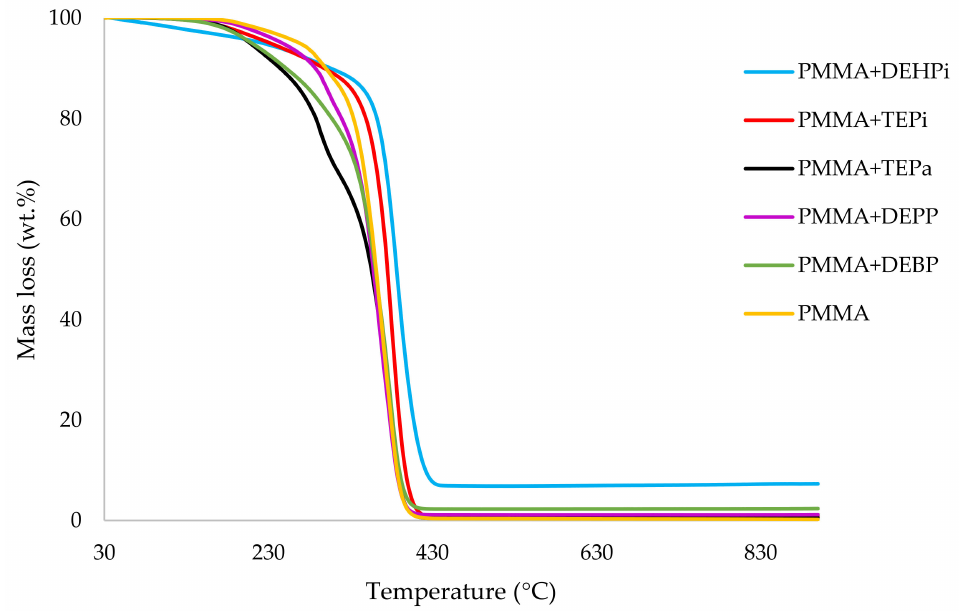
Figure 2. An overlay of the TGA curves of the PMMA-based materials with liquid additives, at 10 ◦ C min − 1